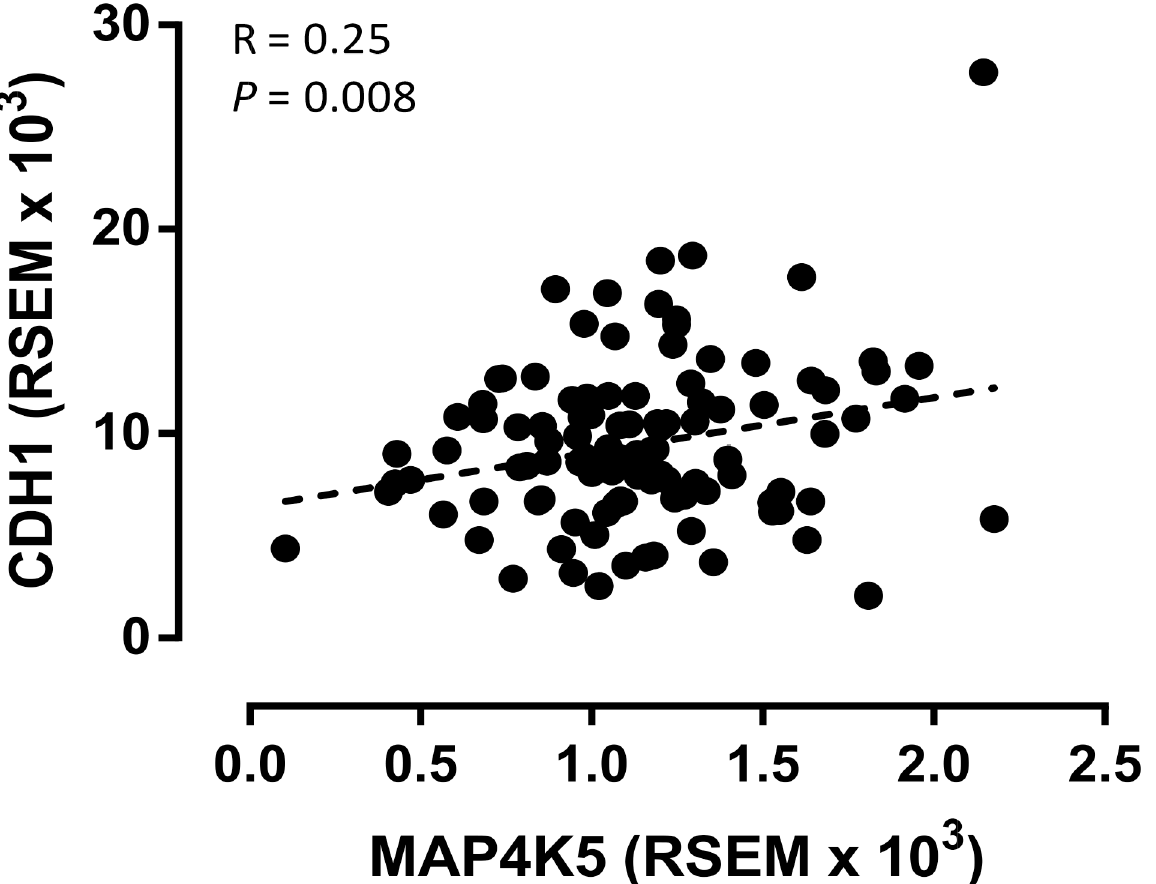
Fig 3. Pearson ’ s correlation analysis between MAP4K5 and CDH1 mRNA expression measured by RNA sequencing analysis in 112 pancreatic ductal adenocarcinoma samples from The Cancer Genome Atlas (TCGA) data portal.